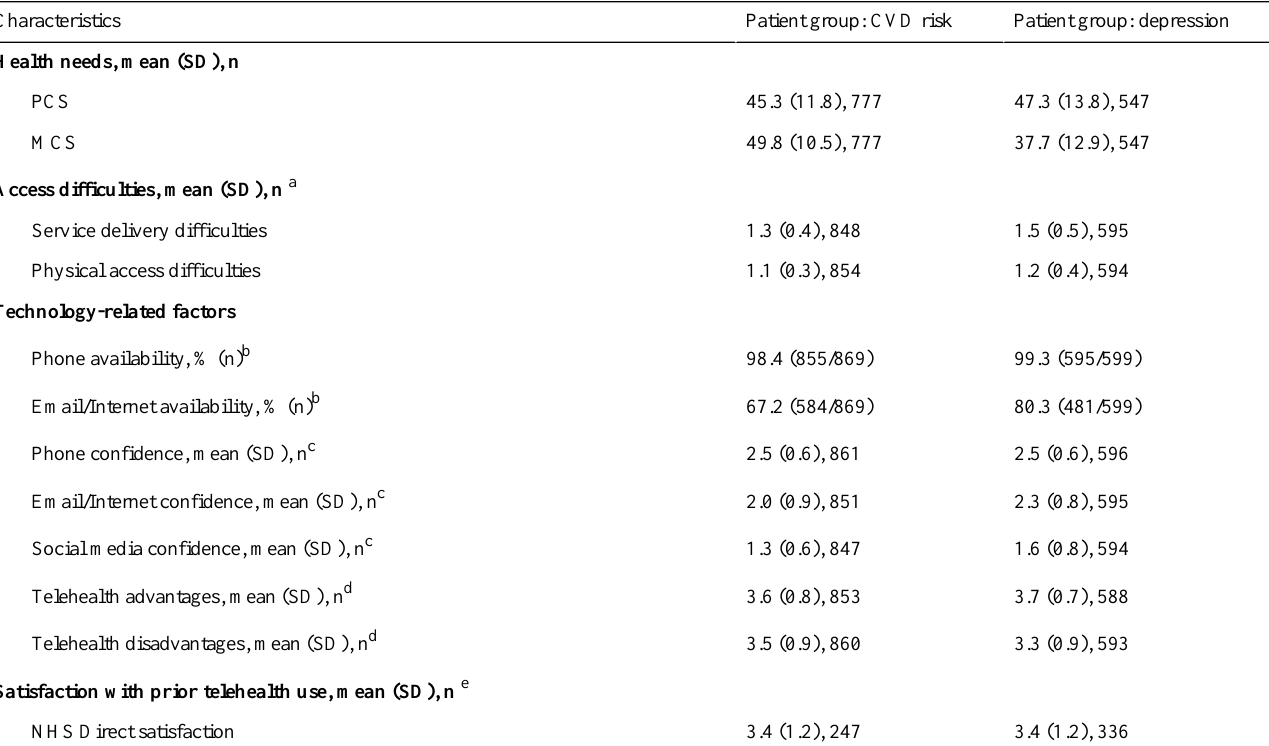
Patient group: depressionPatient group: CVD riskCharacteristics